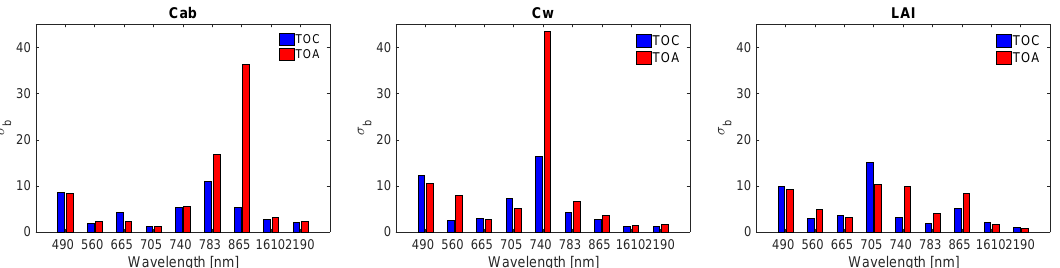
Figure 6. GPR band sigma ( σ b ) for trained models for S2 L2A TOC and L1C TOA data. The lower the σ b , the more important the band in the model